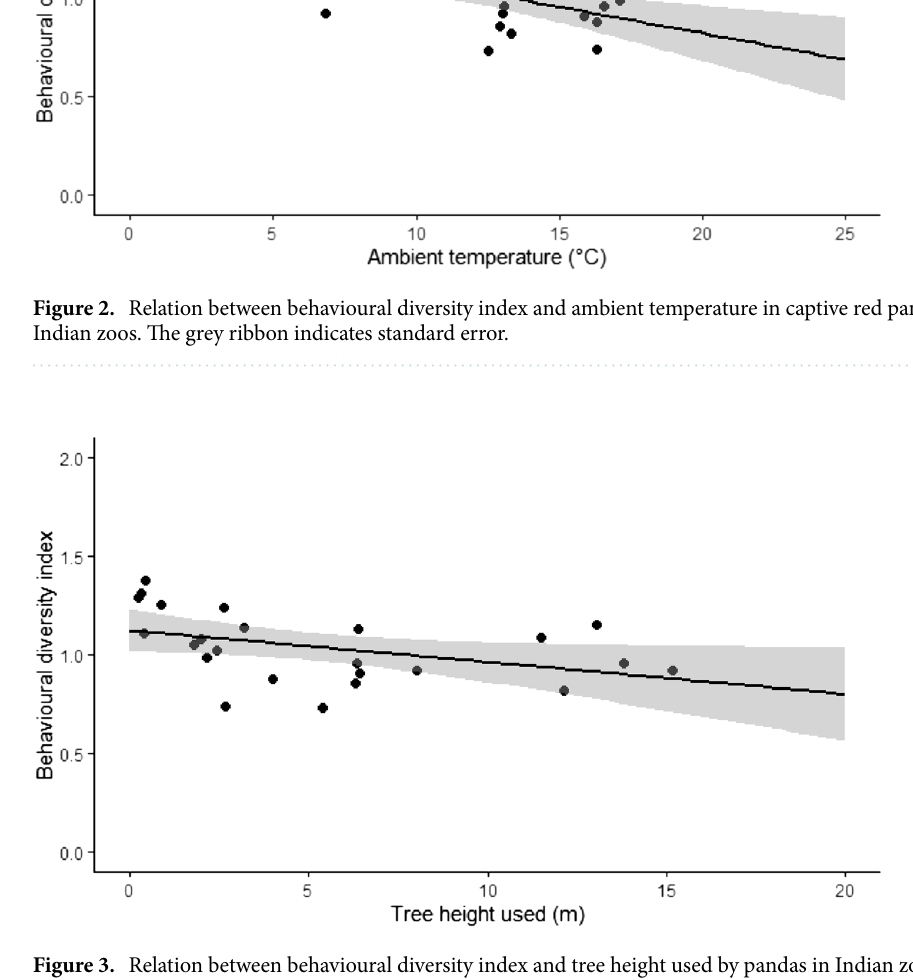
Figure 3. Relation between behavioural diversity index and tree height used by pandas in Indian zoos. The grey ribbon indicates standard